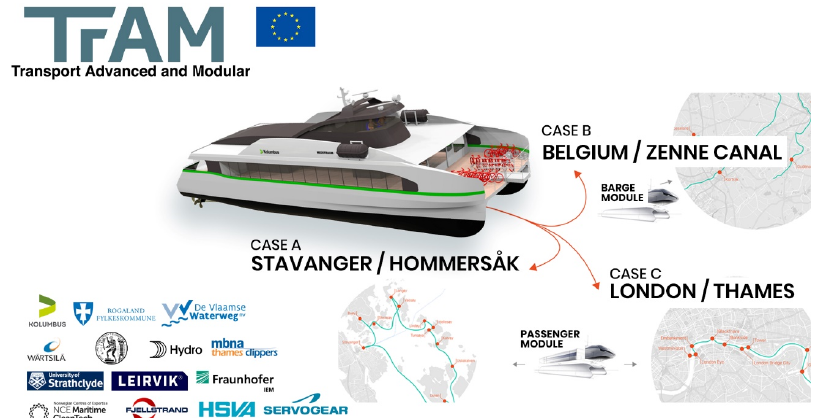
Figure 1. Image of the Stavanger Demonstrator and planned TrAM project replication studies for zero-emission, urban waterborne transport [10] https://tramproject.eu/.